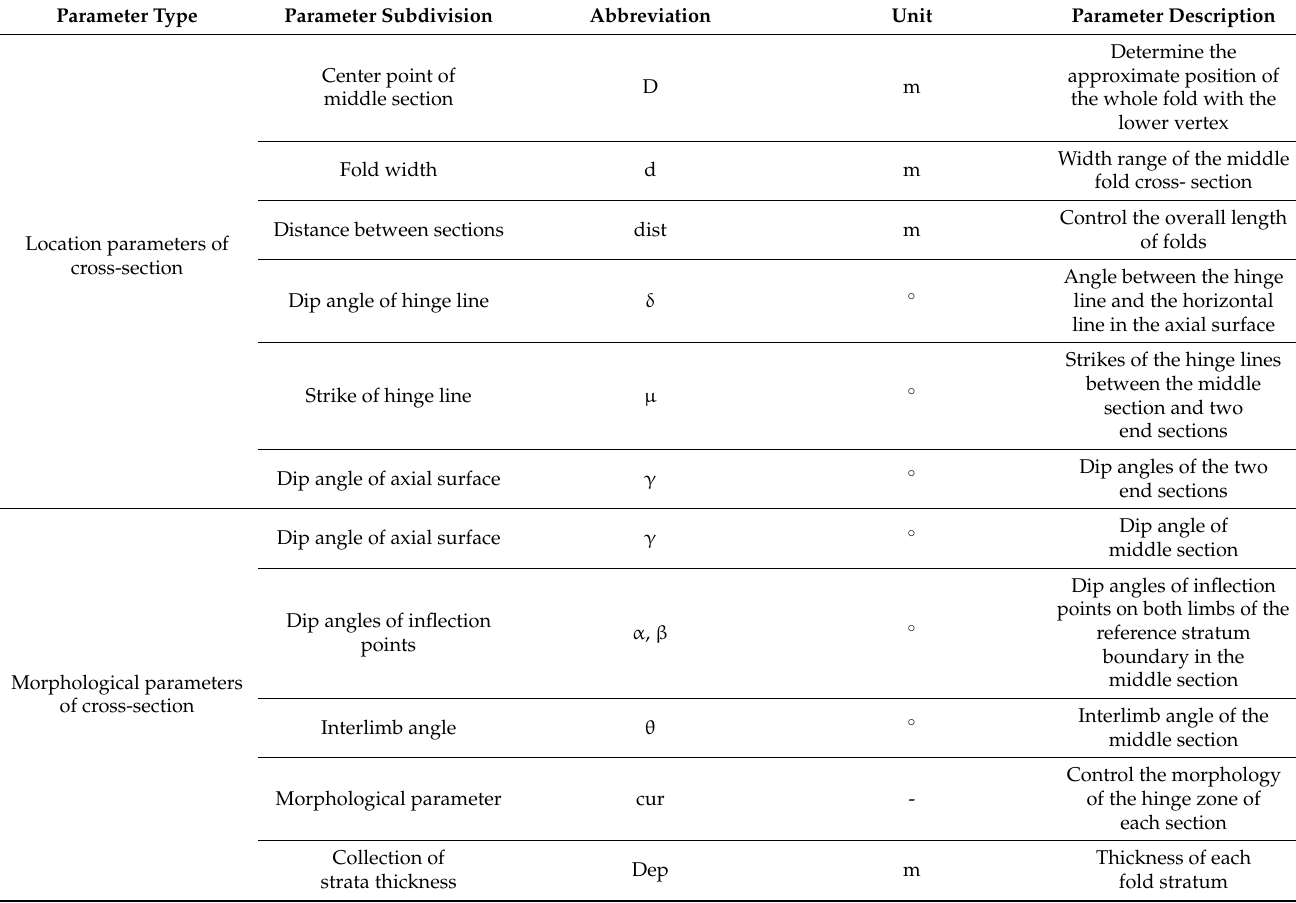
Table 2. Modeling parameters of the fold